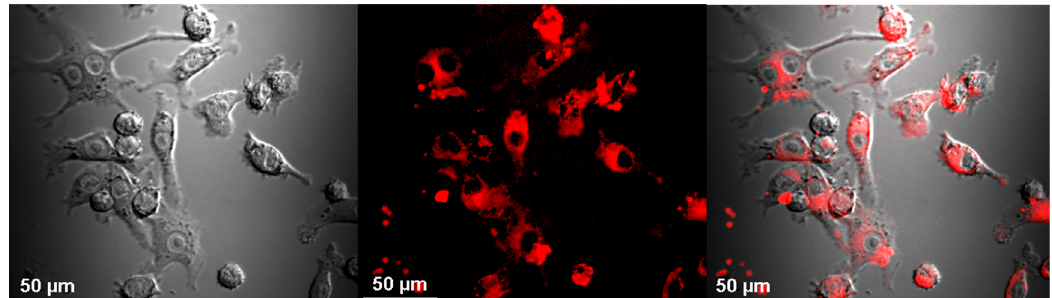
Figure 2. CdTeQD uptake by BV ‐ 2 cells. Confocal image of the cells incubated with CdTeQDs for 2 h 45 min. Magnification 40×, from left to right: DIC microscopy, CdTeQD fluorescence, merged.